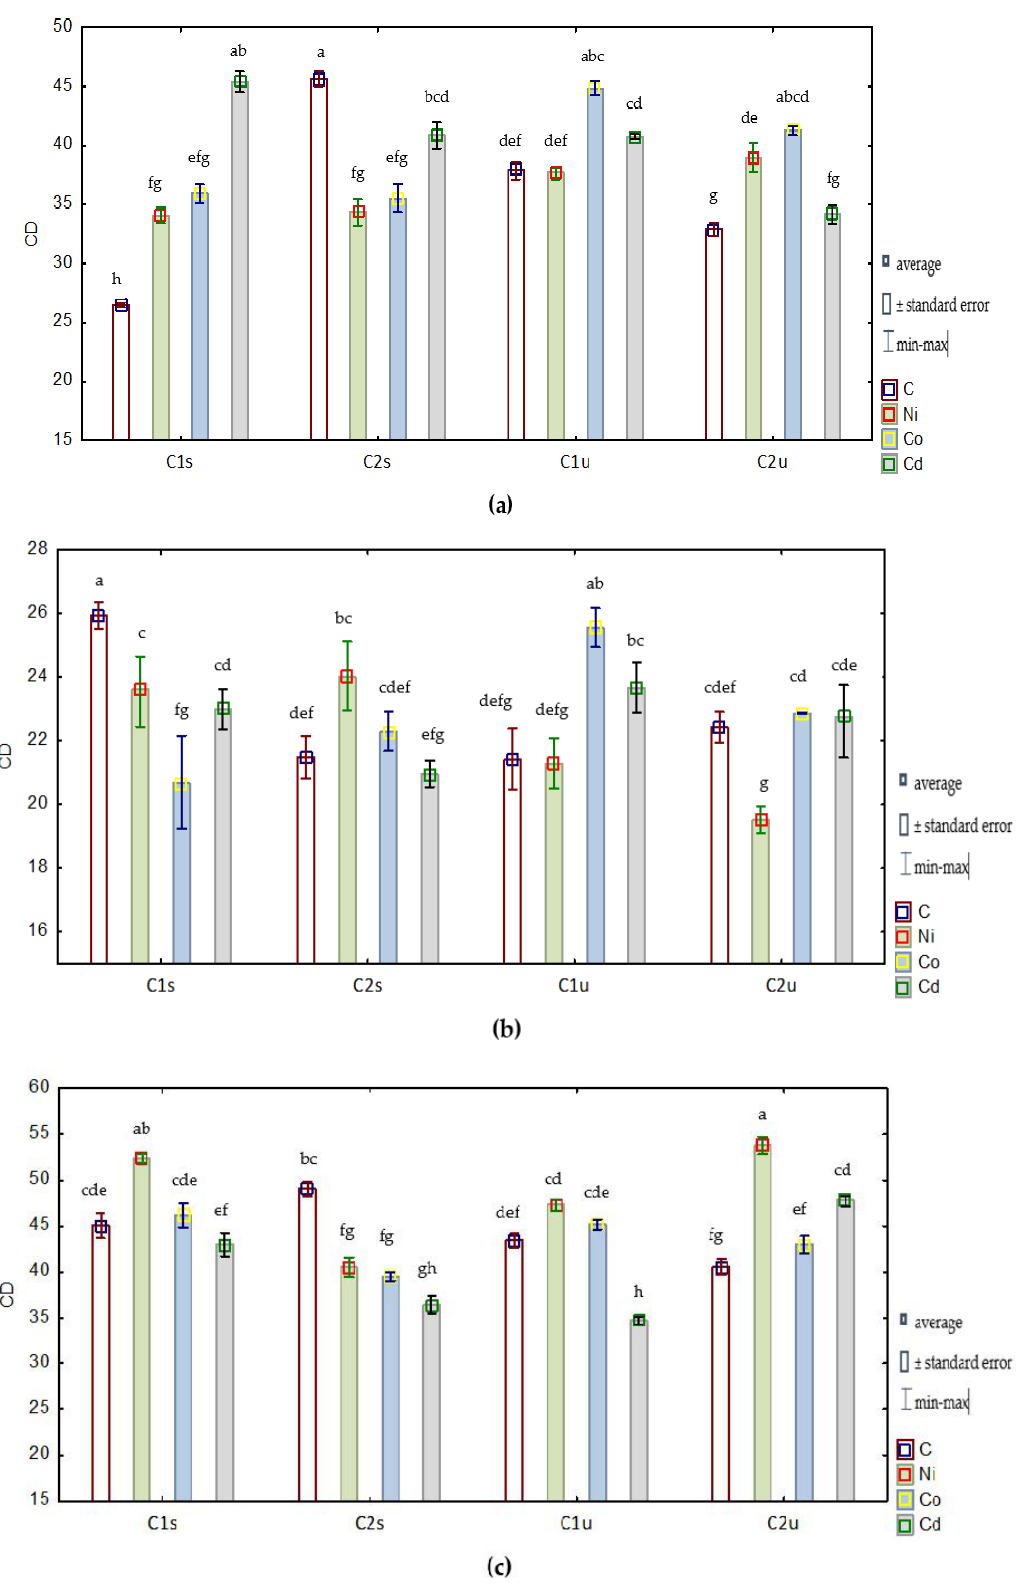
Figure 4. Colony development (CD) index of soil microorganisms. Refer to the key in Figure 2.